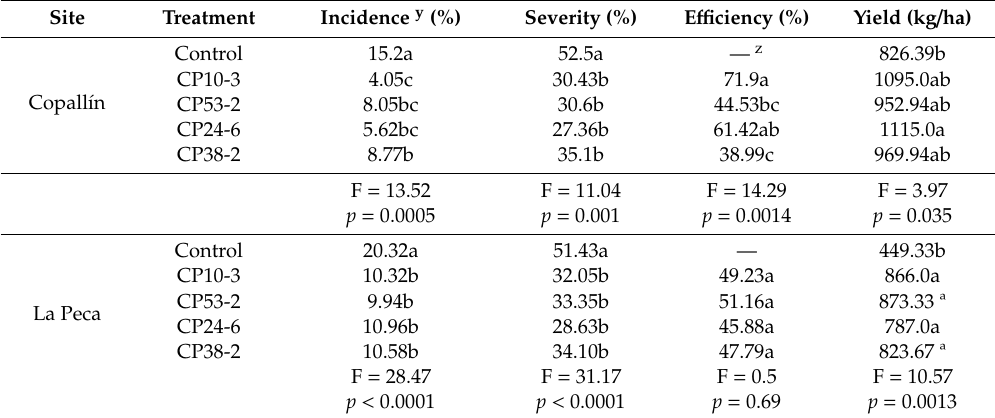
Table 5. E ff ect of four native strains of Trichoderma on epidemiological parameters of frosty pod rot (FPR), production yield, and respective e ffi ciency. ( y Averages with same letters are not statistically di ff erent (Tukey, α = 0.05); z values not calculated due to the character of Abbott’s